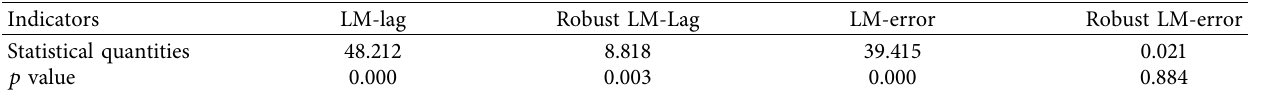
Table 4: Model check results.